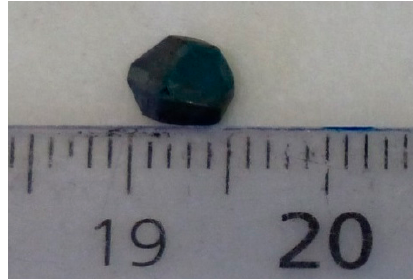
Figure 2. Photography of a millimeter sized MAPI crystal, 6 months after its growth.